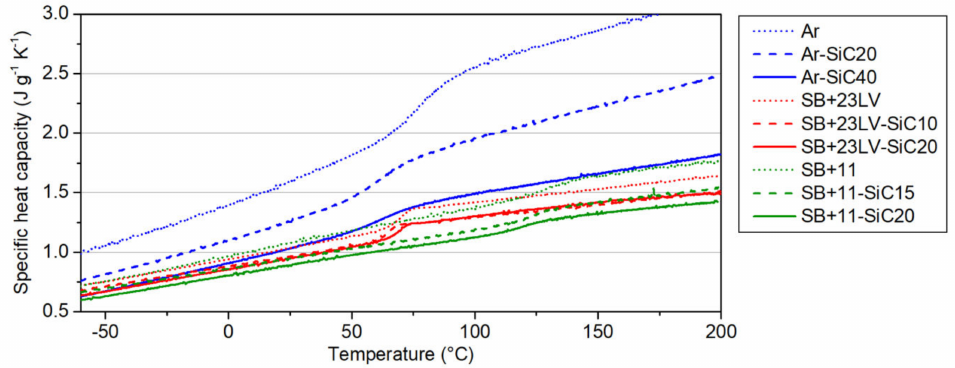
Figure 5. Specific heat capacities as a function of temperature measured in the pure resins and resin–SiC